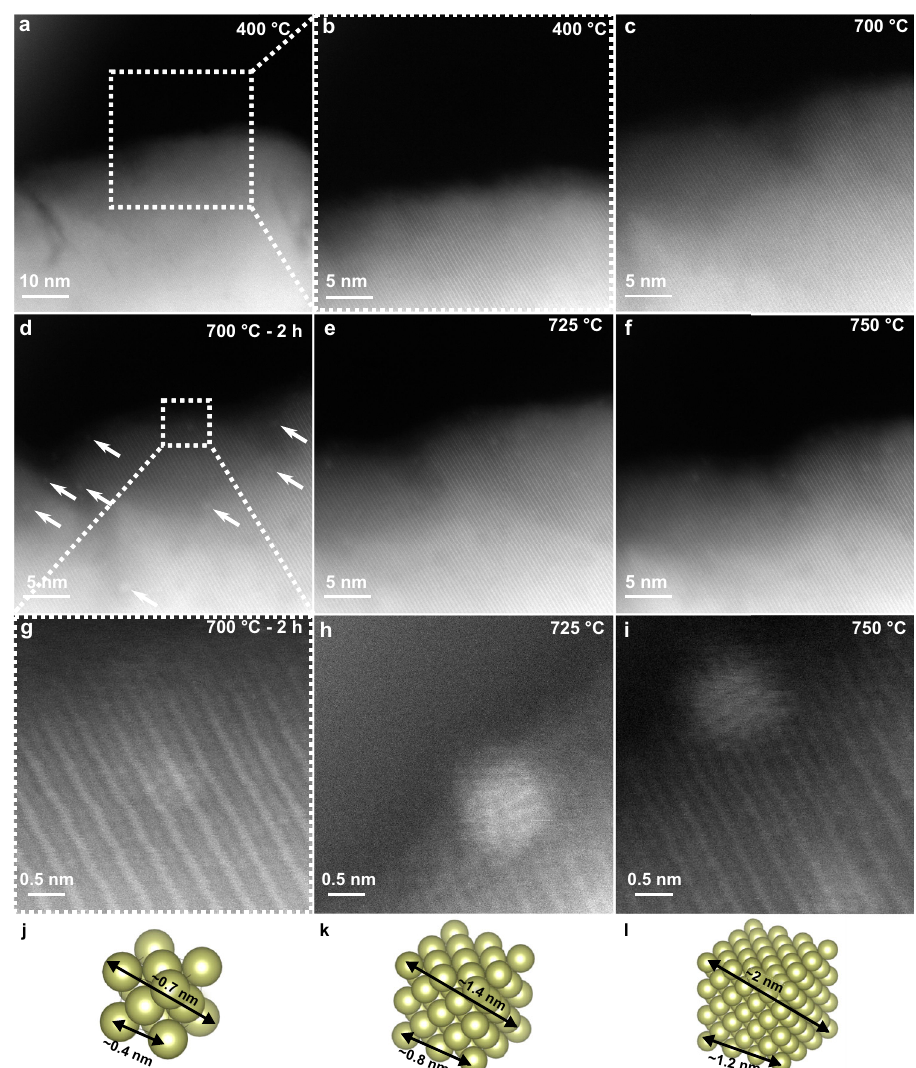
≈ 0.7, ≈ 1.4,and ≈ 2nm acrossin( j ),( k ),and ( l ),respectively. No socketing/epitaxy is possiblein ( j ) with only 14 Ir atoms. Incipient epitaxy starts being observed for the array in ( k ), but the cluster is still small enough to migrate along the surface. Stronger epitaxy is observed (172 Ir atoms cluster) in ( l ) and socketing becomes more likely. Source data are provided as a Source data fi